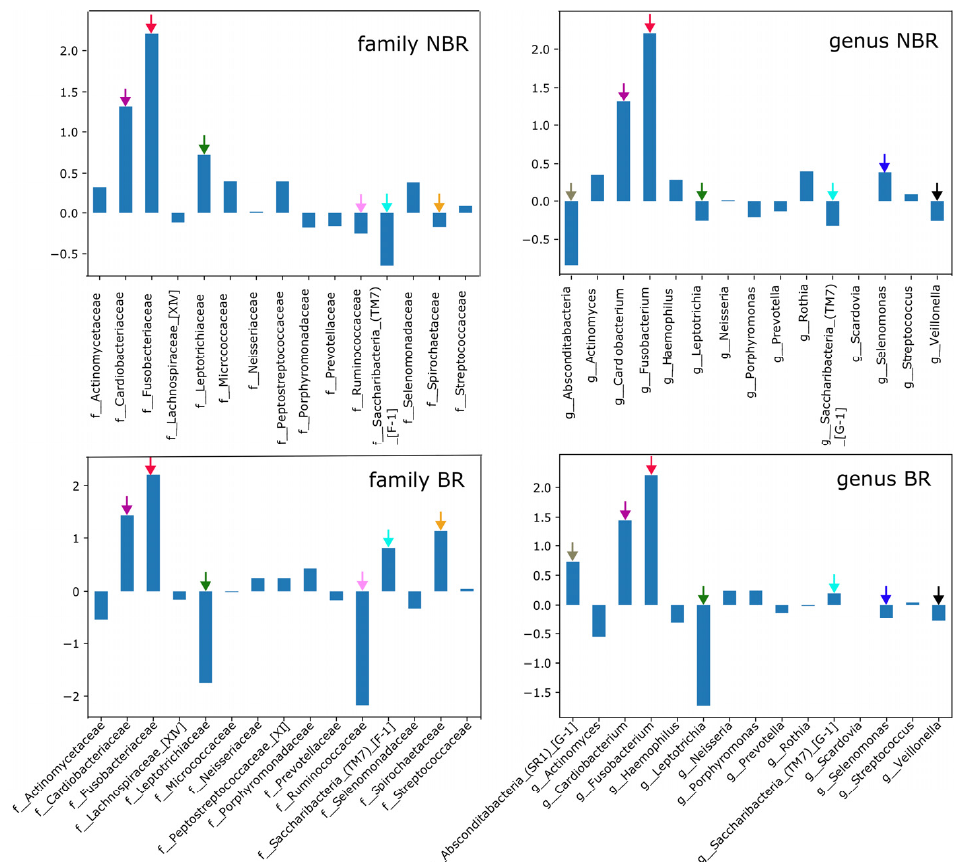
Figure 5. Log2 proportions of remarkable families and genera between NBR and NBR/B (upper colonnades), BR and BR/B (lower colonnades) found by Illumina sequencing in the different groups by toothbrush change after scaling. (Color codes of the most prevalent family and genera are the following: olive: genus Absconditabacteria, purple: family Cardiobacteriaceae, genus Cardiobacterium, red: family Fusobacteriaceae, genus Fusobacterium, green: family Leptotrichiaceae, genus Leptotrichia, lilac: family Ruminococcae, light blue: family and genus Saccharibacteria, yellow: family Spirochaetaceae, indigo: genus Selenomonas, black: genus Veillonella. teriaceae (NBR/B: 2.207, BR/B: 2.206) and followed by Cardiobacteriaceae (NBR/B: 1.31, BR/B: 1.446), and the same tendencies could be observed in the genus Fusobacterium (NBR/B: 2.207, BR/B: 2.206) and Cardiobacterium (NBR/B: 1.31, BR/B: 1.446) during the control, as compared to the periods of chewing gum